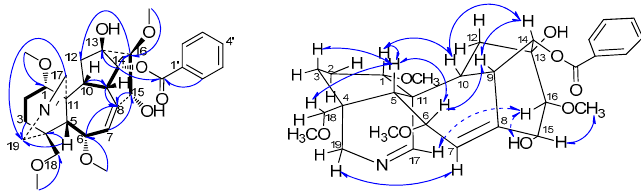
according to the literature [18], compound 1 was assigned the name as (A- c )-14 α -benzoyloxy-8 β - acetoxyl-13 β ,15 α -dihydroxy-1 α ,6 α ,16 β ,18 β -tetramethoxy-19-en-aconitane.